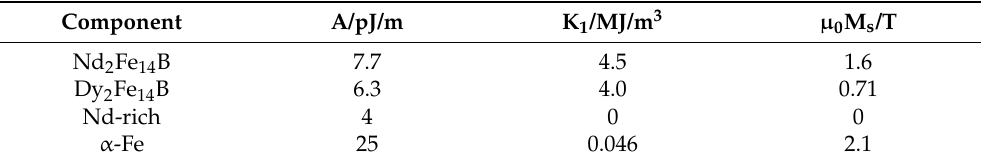
Figure 3. ( a ) Schematic microstructure and magnetic structure of the simulated 3D model used for micromagnetic simulations. Distinct colors indicate specific phases and magnetic orientations. Magnetic orientations of Nd 2 Fe 14 B_1, Nd 2 Fe 14 B_2, Nd 2 Fe 14 B_3, Nd 2 Fe 14 B_4, and Nd(Dy) 2 Fe 14 B were (0.015, 0.085, 0.996), (0.173, 0.015, 0.985), (0.146, 0.253, 0.858), (0.114, − 0.042, 0.992), (0.033, 0.012, 0.999), respectively. ( b ) Simulated demagnetization and initial magnetization curves of the models Table 2. Material parameters of each phase for micromagnetic simulations. α -Fe is the cubic structure, and K1 is a typical anisotropy constant of the soft-magnetic phase [15].